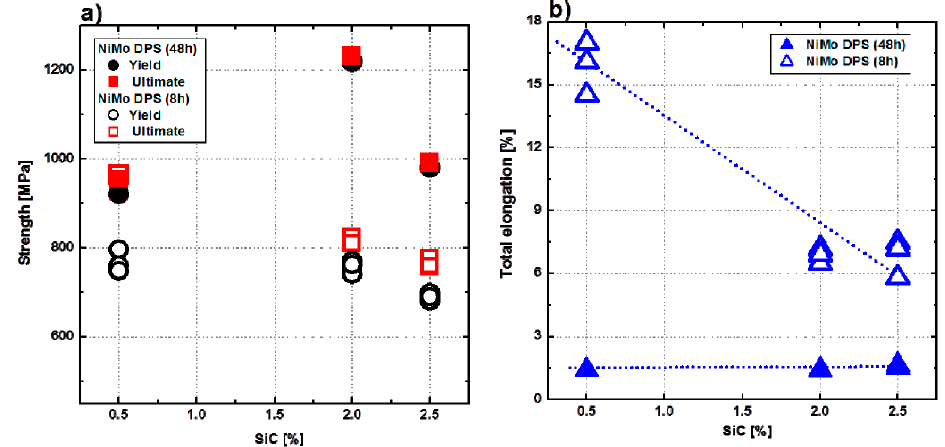
Figure 1. Variations of ( a ) yield and tensile strength; and ( b ) total elongation of 48-h-milled and 8-h-milled NiMo-SiC dispersion and precipitation-strengthened (DPS) alloys with an increasing amount of SiC in the initial powder mixture.